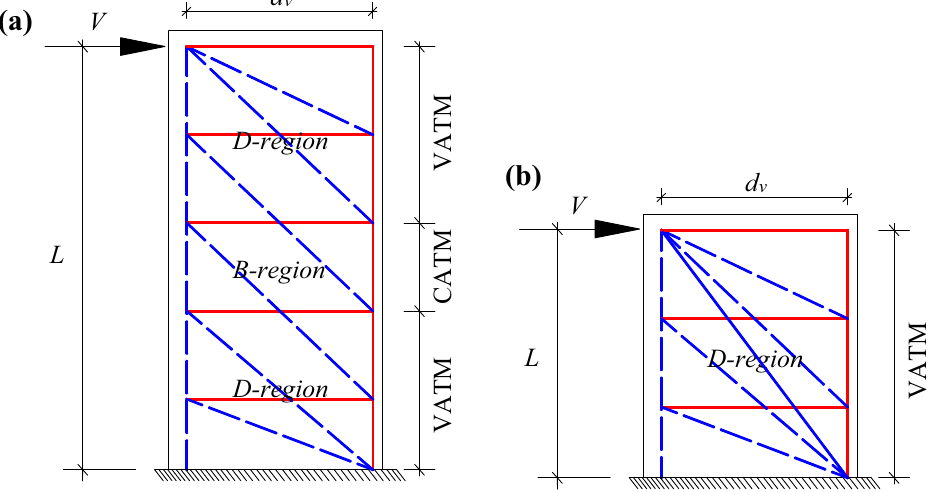
Fig. 1 Truss analogy modeling for RECC columns with different k . a Combined truss model for high k b VATM for low k